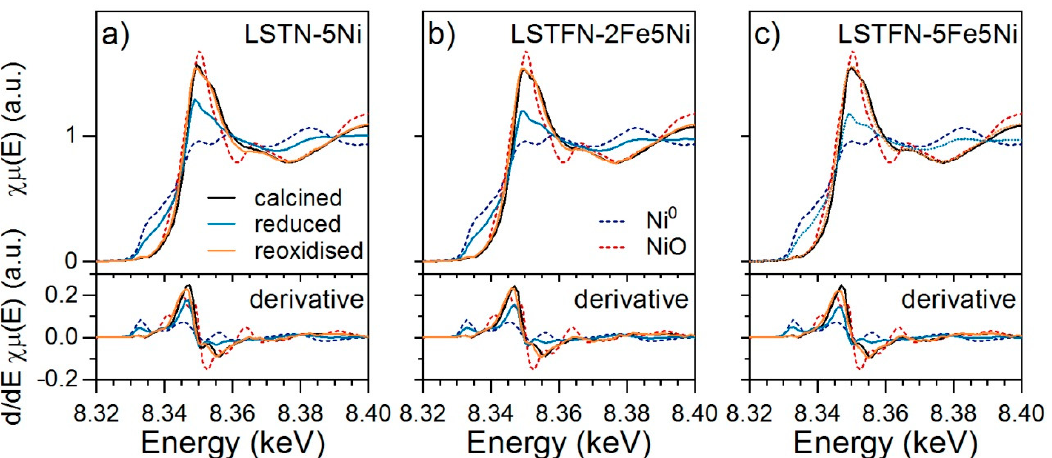
Figure 7. Normalized Ni K-edge (8.333 keV) XANES spectra of ( a ) calcined and reduced (10 vol.% H 2 /Ar, 800 ◦ C, 15 h) LSTN-5Ni, ( b ) LSTFN-2Fe5Ni and ( c ) LSTFN-5Fe5Ni. Plots of the first derivative of the normalized spectra are shown in the bottom panels. The spectra of Ni foil and NiO reference materials are included for comparison (dashed lines).